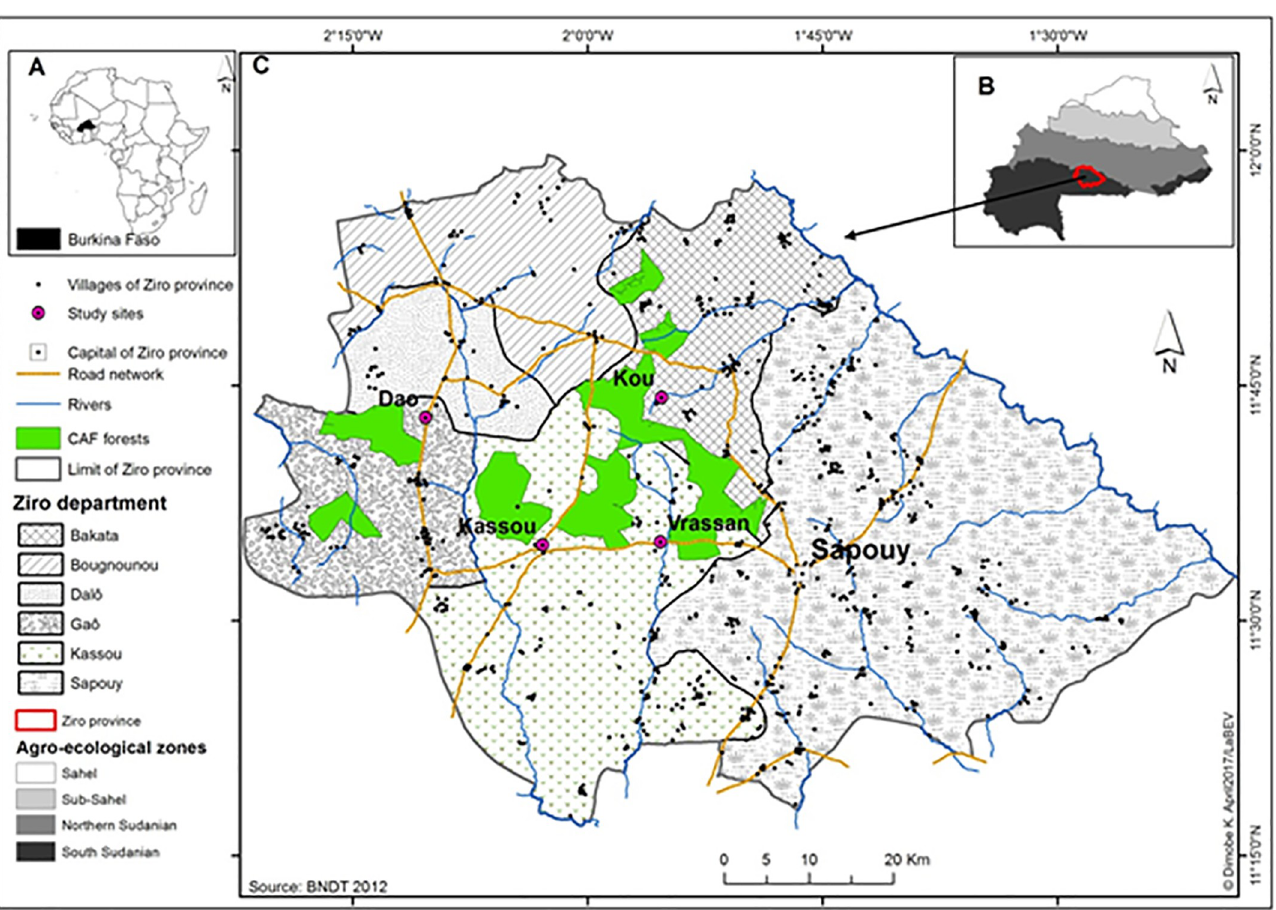
Fig 1. Location of the study area. (A) the location of Burkina Faso in Africa, (B) the position of province of Ziro in Burkina Faso, and (C) the province of Ziro with study sites. Study sites are indicated by circles while polygons show the limits of managed forest under the CAF